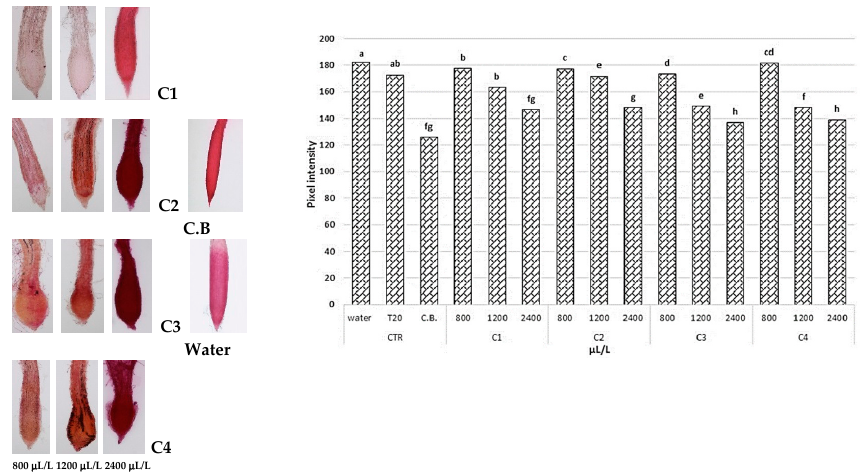
Figure 5. Effect of different chemotype EO concentrations on the intensity of lipid peroxidation in roots of L. perenne stained with Shiff’s (left) and relative pixel intensity (lower intensity indicates a higher staining red intensity and a higher lipid peroxidation) (right). C1 : α -pinene, C2 : camphor, C3 : α -pinene/1,8-cineole, C4 : α -pinene/camphor/1,8-cineole. CTR: water, T20: Tween 20 and C.B : Commercial bio-herbicide. Means with the same letter are not significantly different at p ≤ 0.05 significant level (Tukey’s test).